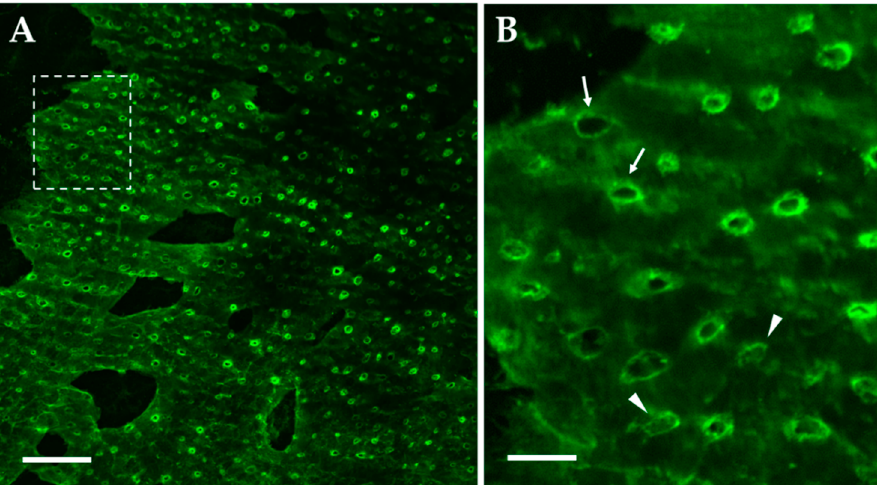
Figure 1. ( A ) Confocal image of a mouse diaphragmatic submesothelial lymphatic lacuna immunohistochemically stained with the fluorescent lymphatic vessel endothelial hyaluronan receptor (LYVE-1), a lymphatic endothelial marker. Several circular stomata are observable covering the entire surface of the lacuna. Bar: 50 µm. ( B ) Higher magnification of the lacuna surface delimited by the dashed line on Panel A. Stomata may show either a completely open (thin arrows) or closed (arrowheads) conformation. Bar: 20 µm. Table 1. Average density, total stomata area (expressed as % of total area of submesothelial lacunae) and stomata radius in diaphragmatic lymphatics. PL-T: pleural-tendinous; PL-M: pleural-muscular; PE-T: peritoneal tendinous; PE-M: peritoneal-muscular. Data are presented as mean ± SD. Number of observation in